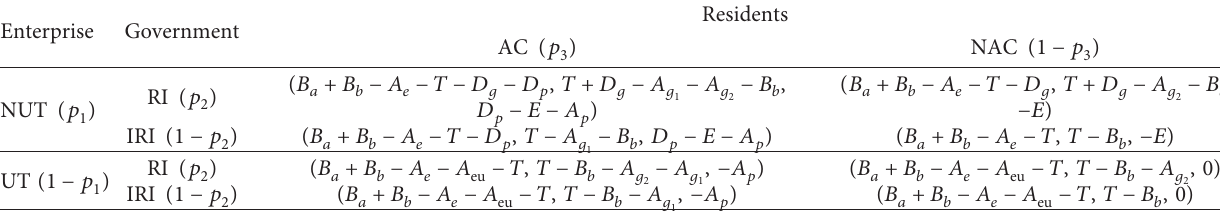
Table 2: Payoffs matrix for the three players.